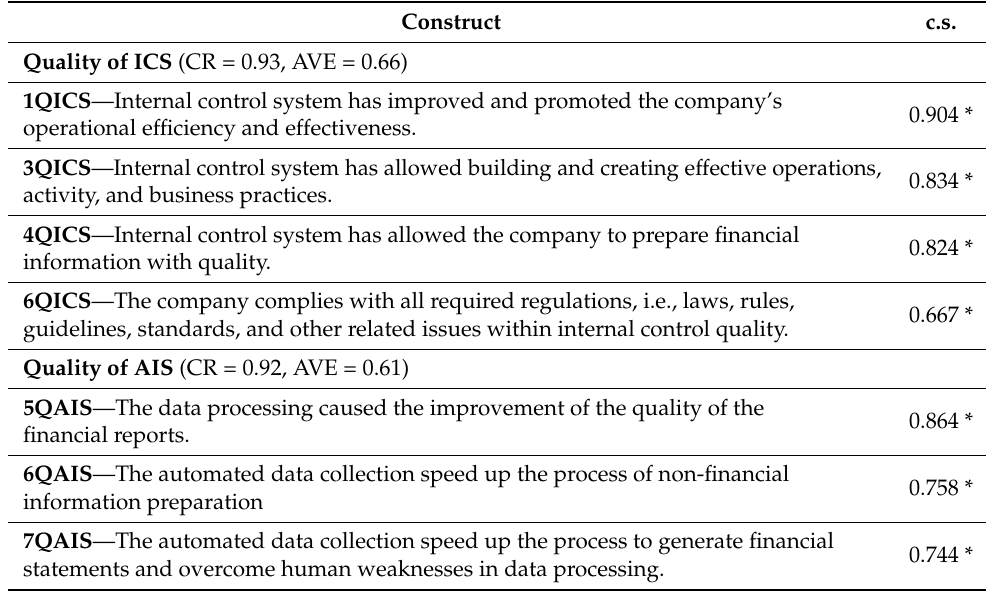
Table 1. Confirmatory factor analysis